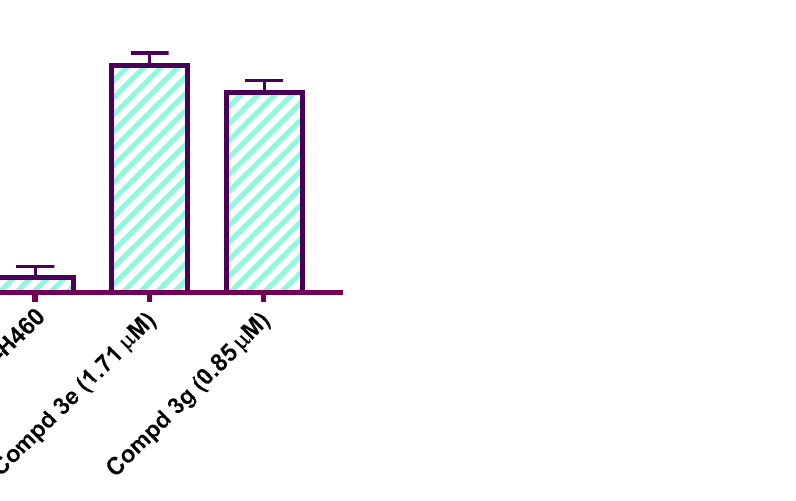
Figure 5. ELISA results of active c aspase-9 in NCI-H460 cells treated with benzimidazole molecules 3e and 3g at their IC 50 concentration ( µ M) after 24 h.